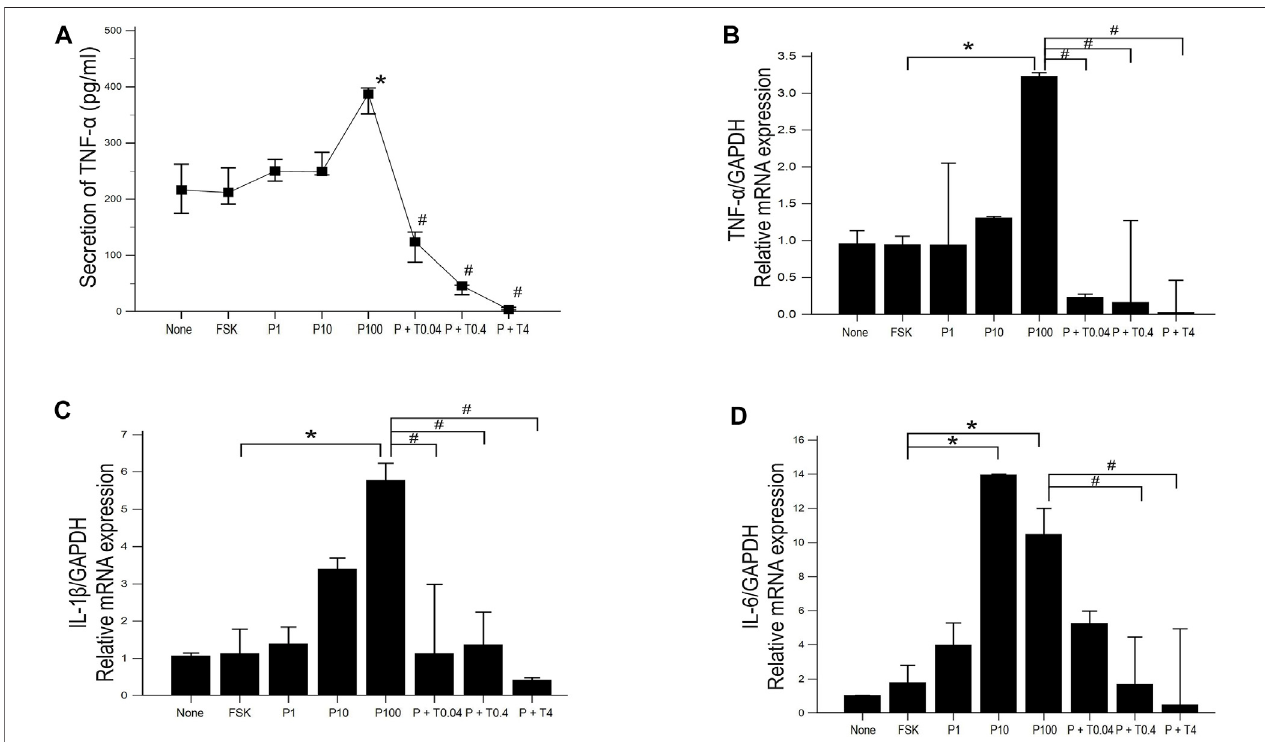
FIGURE 5 | Expression and secretion of proin fl ammatory cytokine in 50B11 cells. (A) TNF- α secretion was determined by ELISA in culture medium under serum-free conditions and different treatments ( n = 3 per group; # p < 0.05 compared to the P100). (B – D) Total RNA was isolated, and quantitative PCR was performed. Ct (threshold cycle) values were calculated, and the Δ Ct method was used for relative mRNA quanti fi cation. The expression levels of genes were normalized to that of GAPDHandshowedasigni fi cantincreaseinthemRNAlevelsoftheproin fl ammatorycytokinestumornecrosisfactor(TNF)- α ,interleukin(IL)-1 β ,andIL-6( n =3per each group). Data were presented as the median and interquartile range (IQR) and analyzed using the Kruskal-Wallis test followed by the Conover test. * p < 0.05 compared to the FSK; # p < 0.05 compared to the